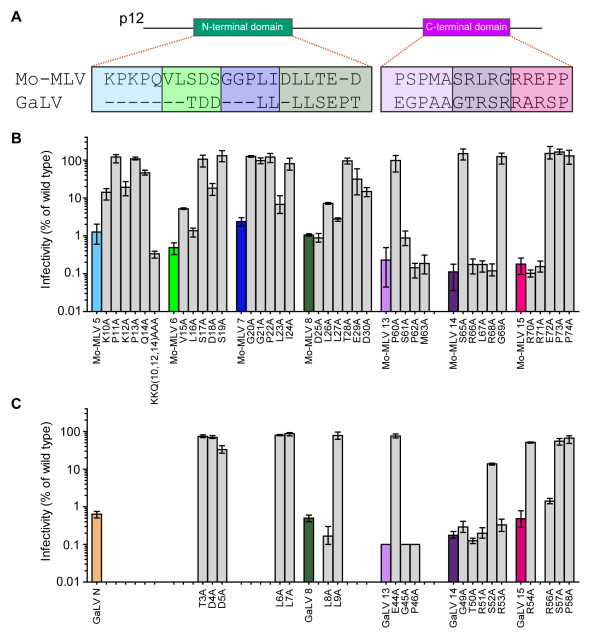
Infectivity of Mo-MLV and GaLV with single amino acid changes in p12. (A) An alignment of the residues comprising the N- and C-terminal domains of p12 in Mo-MLV and GaLV is shown. Colour shading indicates the original Mo-MLV p12 substitution mutants synthesized. (B and C) Single alanine substitutions were made for each residue within these domains for Mo-MLV p12 (B) or GaLV p12 (C). LacZ-encoding mutant VLPs were synthesized and equivalent RT-units of VLPs were used to challenge D17 cells. Infectivity was measured by detection of β–galactosidase activity in a chemiluminescent reporter assay. Results are plotted as the percentage of infectivity compared to the infectivity of the corresponding wild type VLPs for each species. The mean and range of three independent experiments are shown.